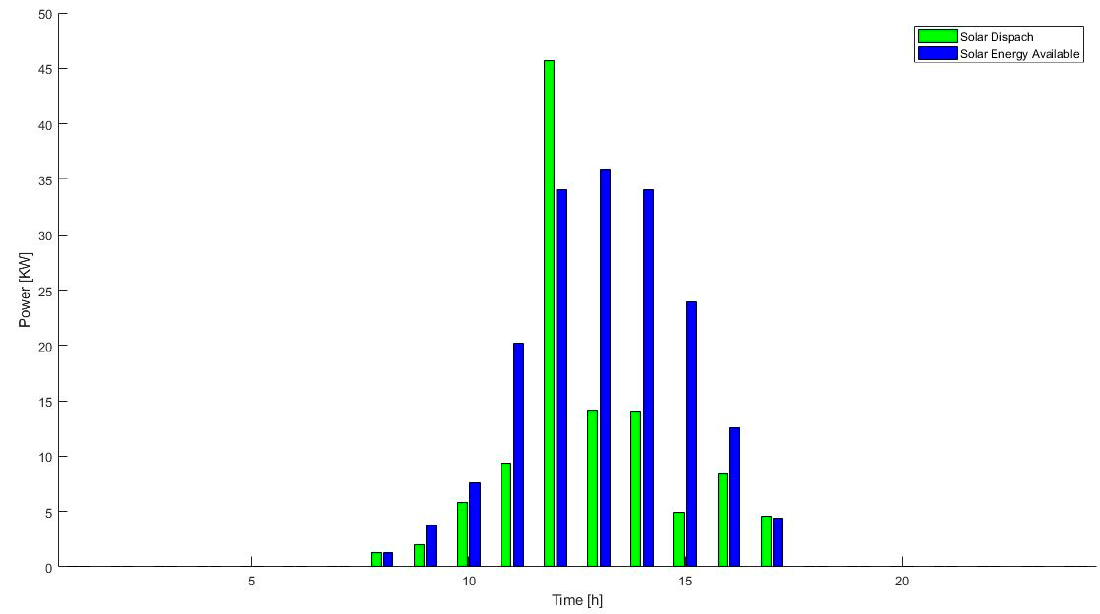
Figure 2. Photovoltaic power dispatched (green) vs. the most probable power curve (blue) during 24 hours every day.